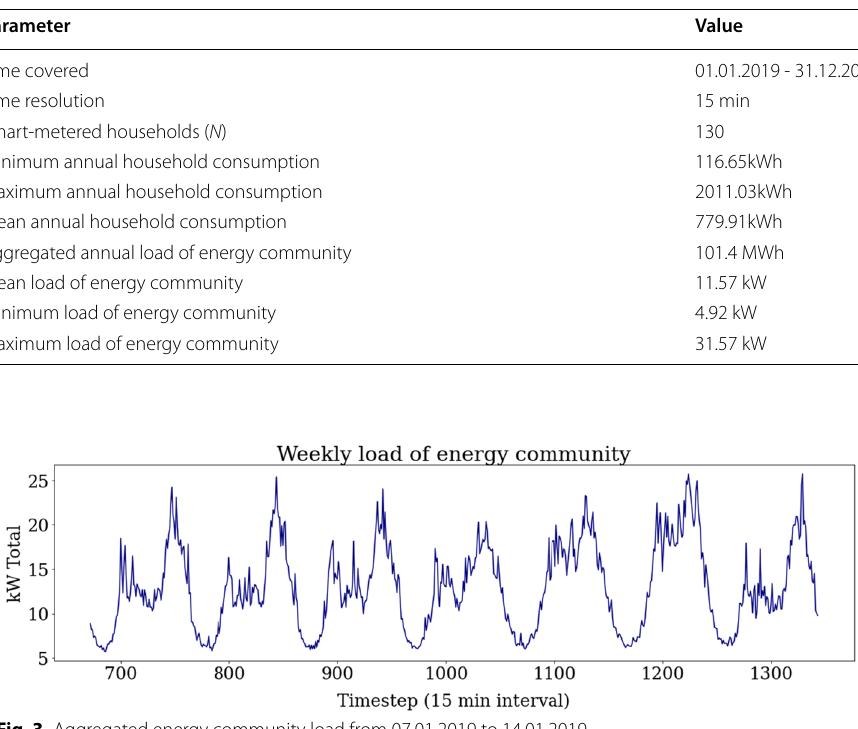
Fig. 3 Aggregated energy community load from 07.01.2019 to